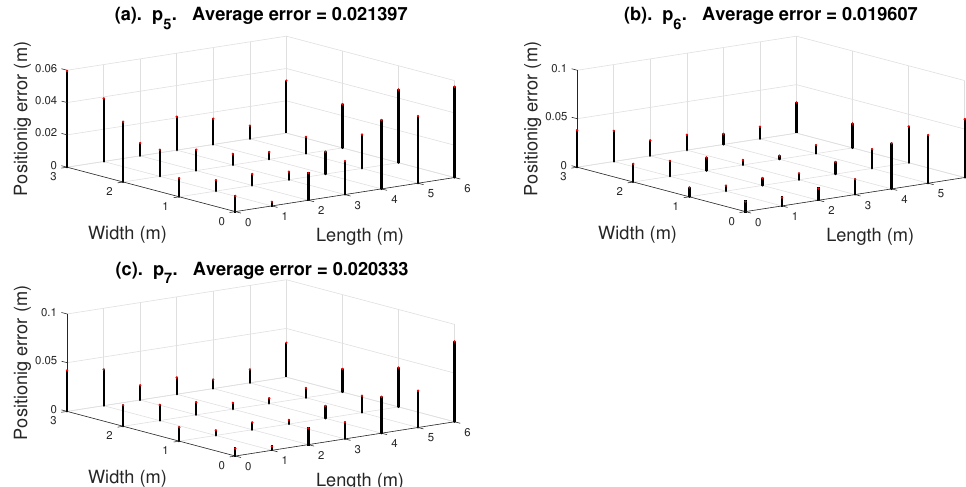
Figure 7. Positioning error for chromatic points p 5 to p 7